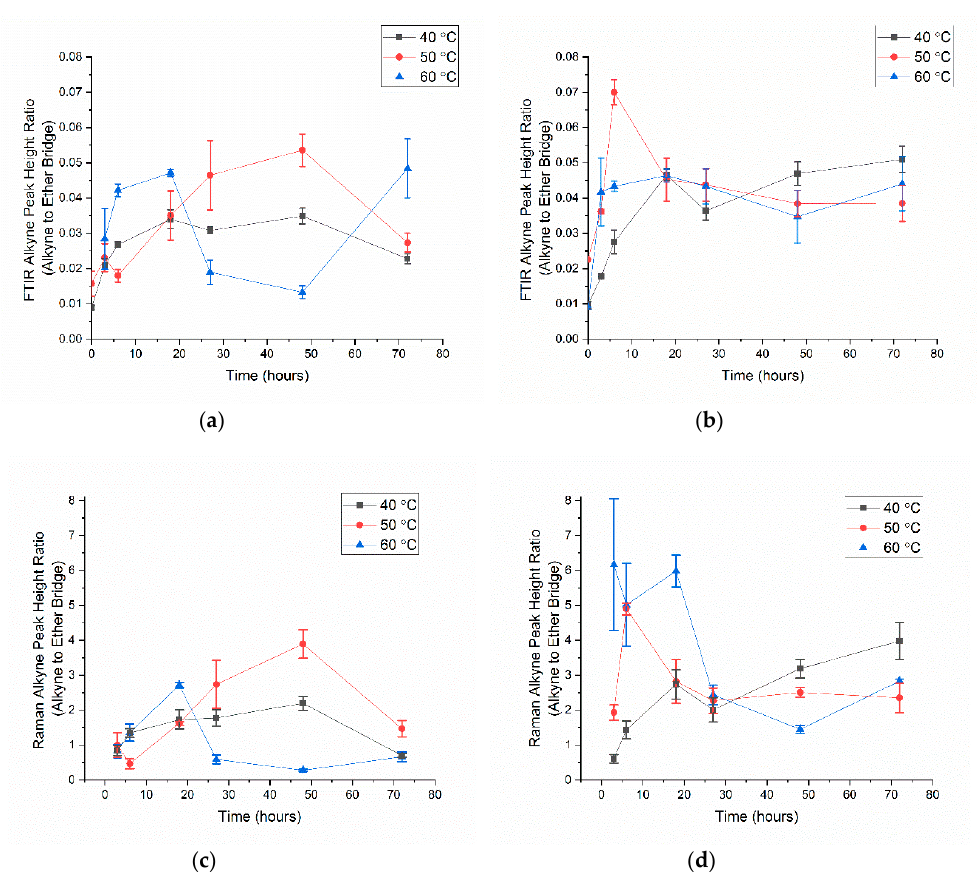
Figure 3. Alkyne substitution reaction yield as a function of temperature and time compared using ( a , b ) FTIR and ( c , d ) Raman spectra’s alkyne peak height ratios for ( a , c ) one-step and ( b , d ) two-step RC nanofibers